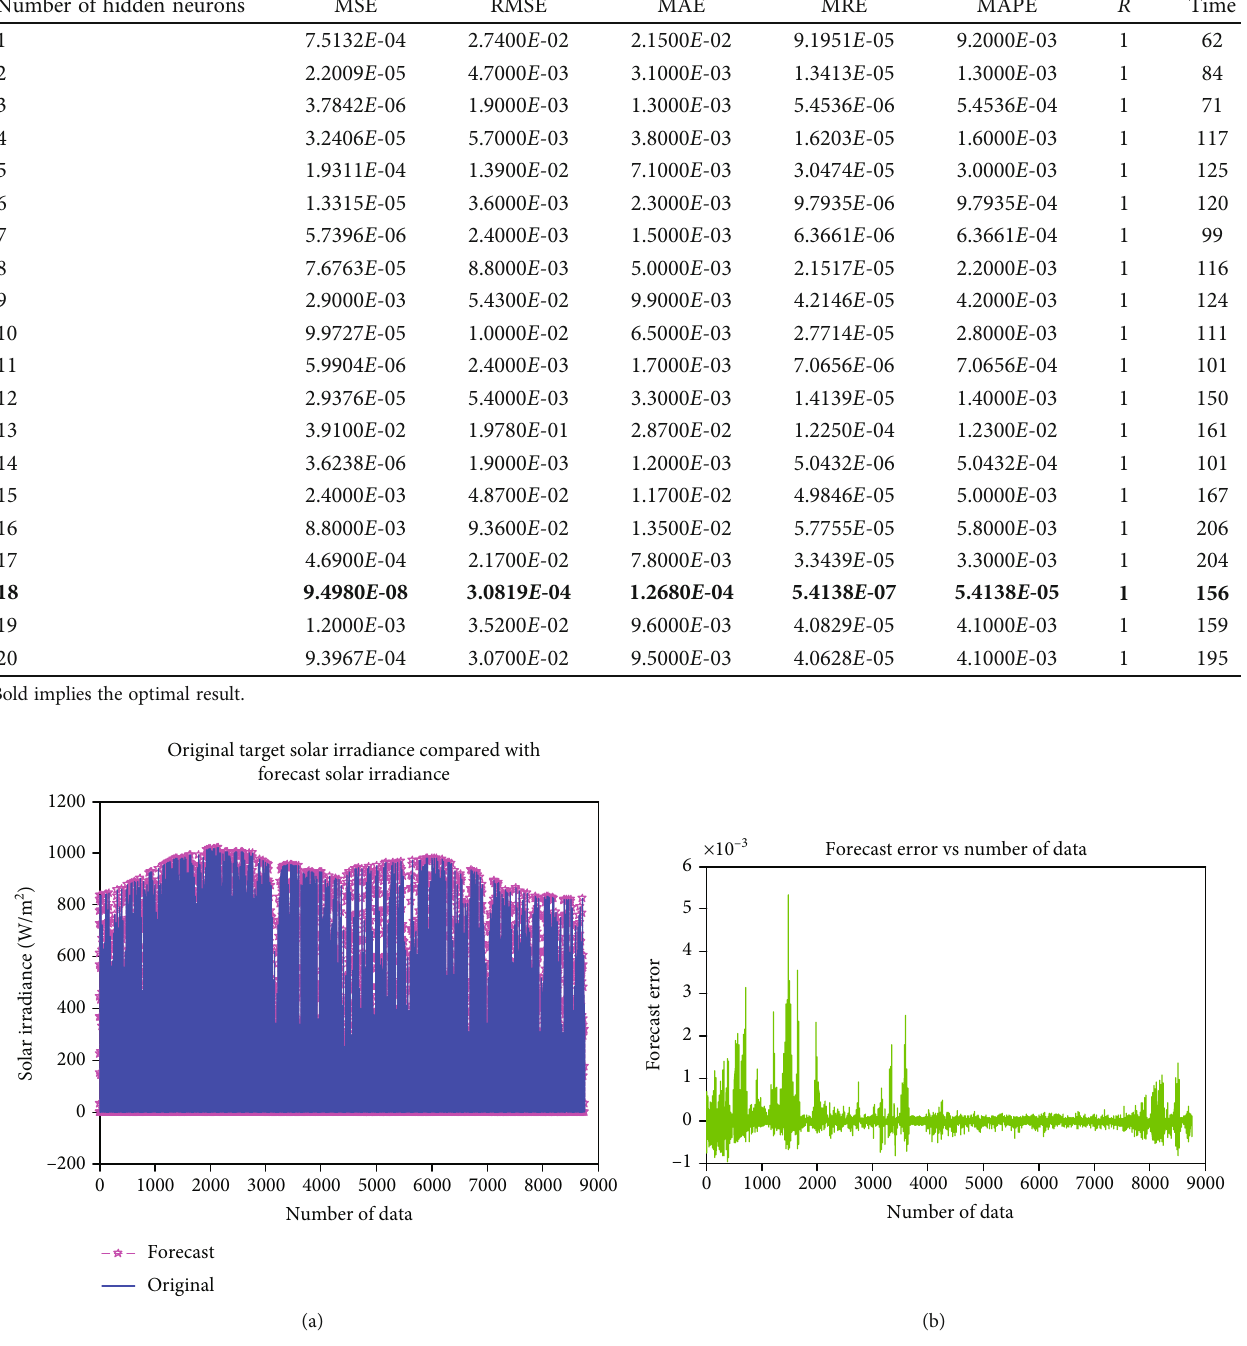
Table 4: Three input multilayer perceptron neural network performance analyses with a di ff erent number of hidden neurons. Number of hidden neurons